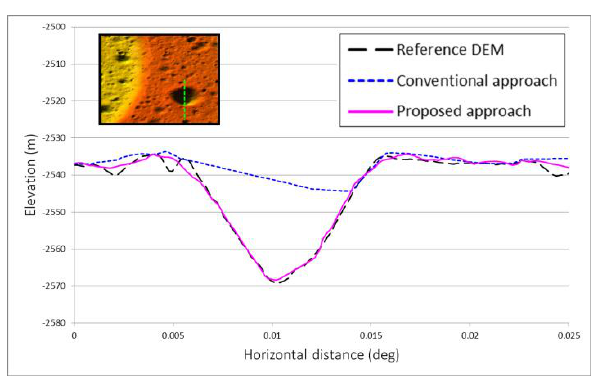
Figure 10. 3D views of DEMs of the experimental